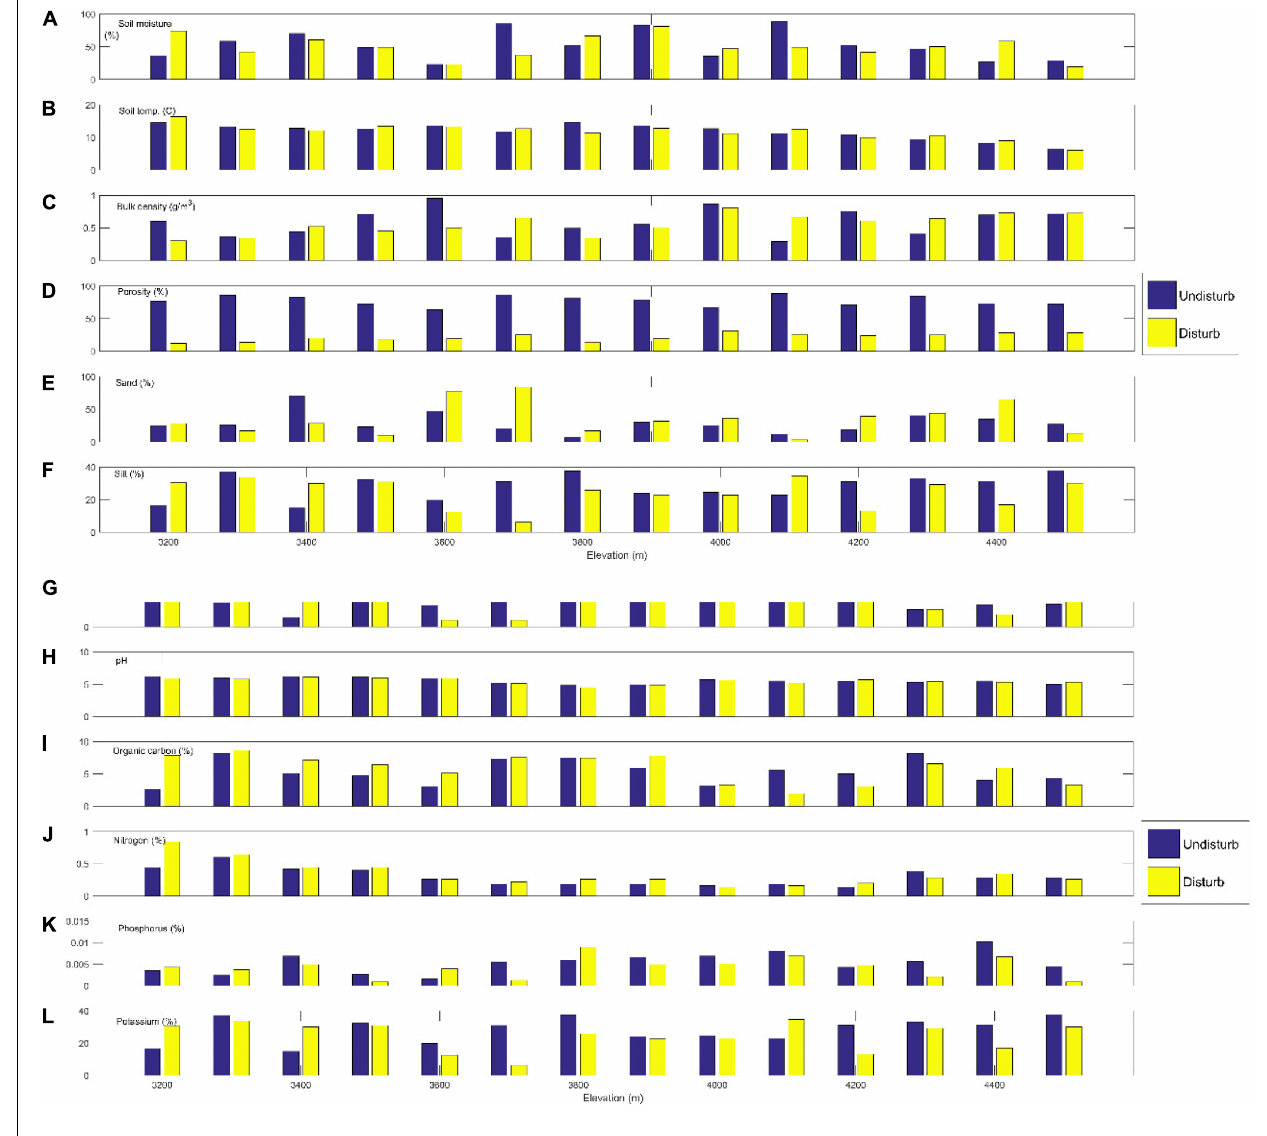
FIGURE 7 | Physicochemical properties of soil for undisturbed and disturbed sites in